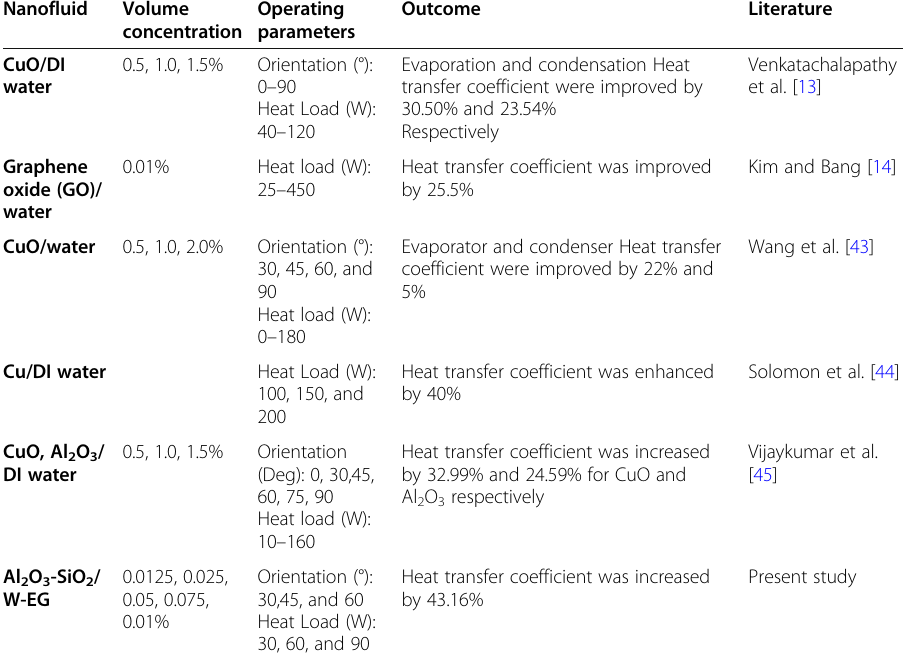
Table 1 Comparison in heat transfer performance of screen mesh type wick structure cylindrical heat pipe using nanofluids with present